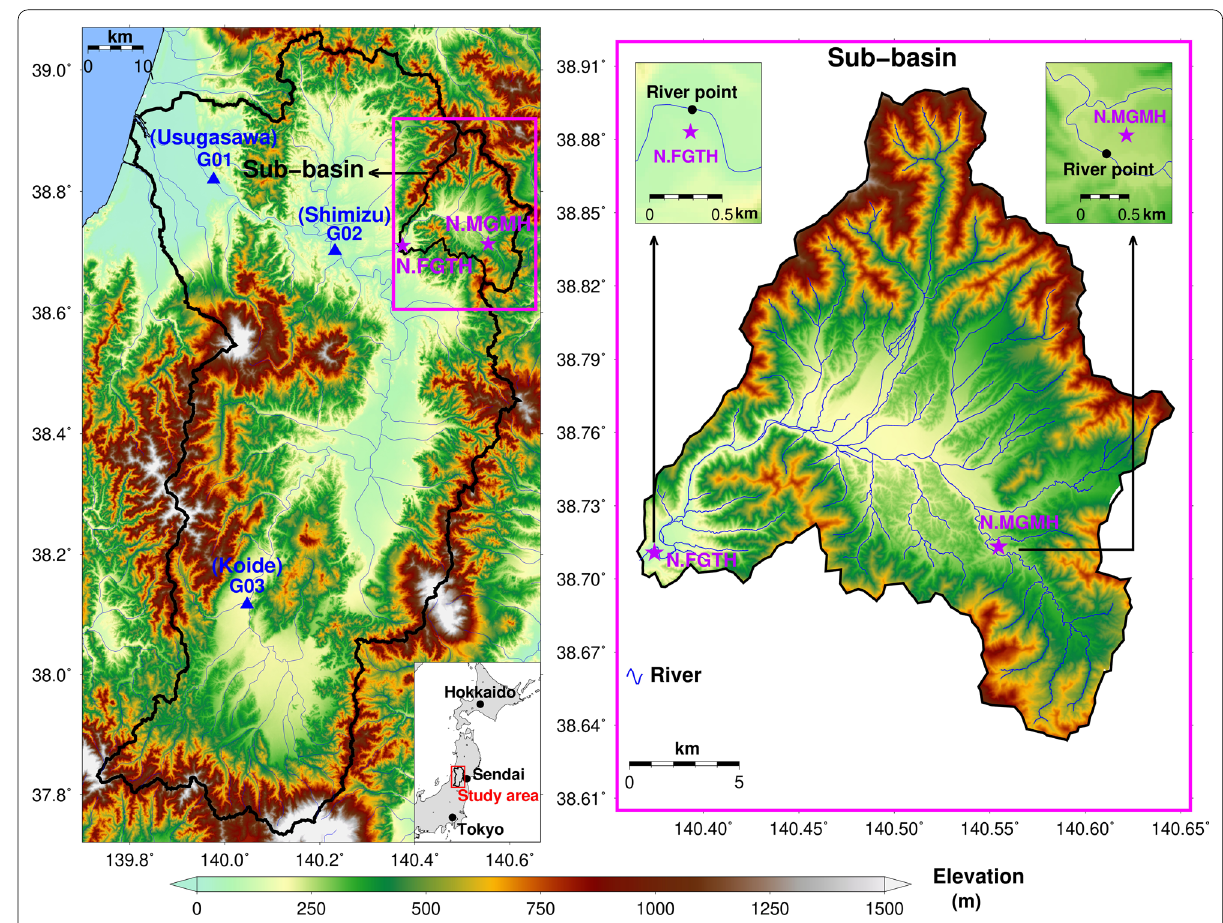
Fig. 1 Topographic map showing the location and channel networks of the Mogami River Basin and its sub-basin. Blue triangles indicate hydrological stations. Purple stars and black dots indicate seismic stations and selected river points within the sub-basin,